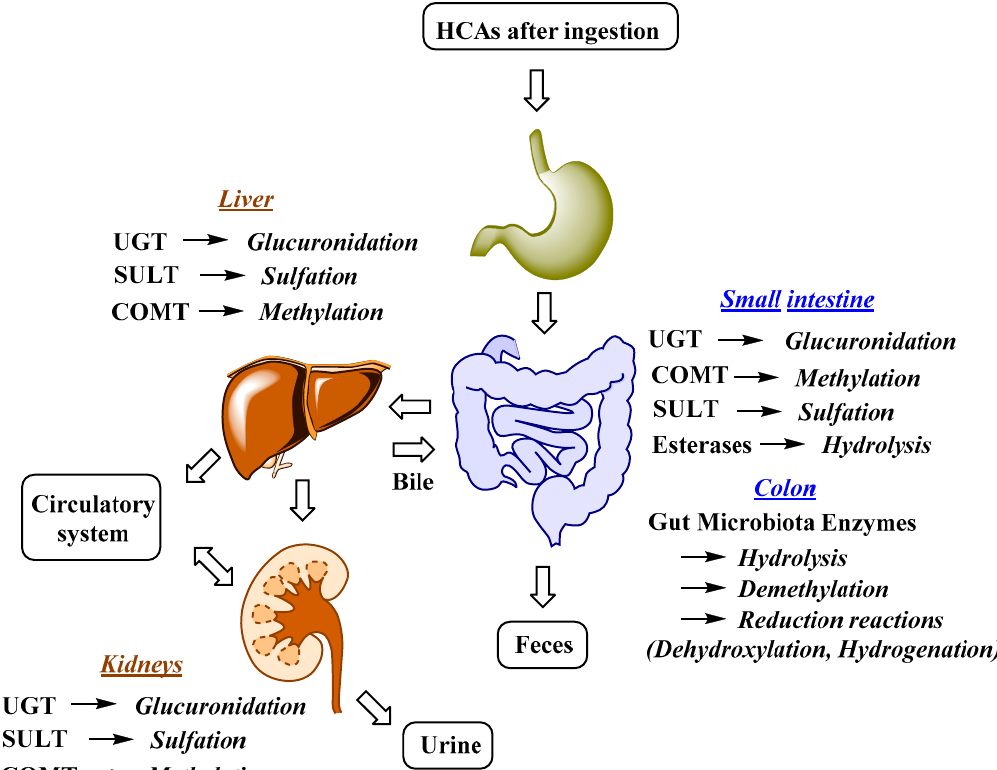
Figure 2. Major metabolic reactions, enzymes and organs involved in HCAs metabolism; UGT, uridine-5 ′ -diphosphate-glucuronosyltransferase; COMT, catechol-O-methyltransferase; SULT, sulfotransferase [62,63] .